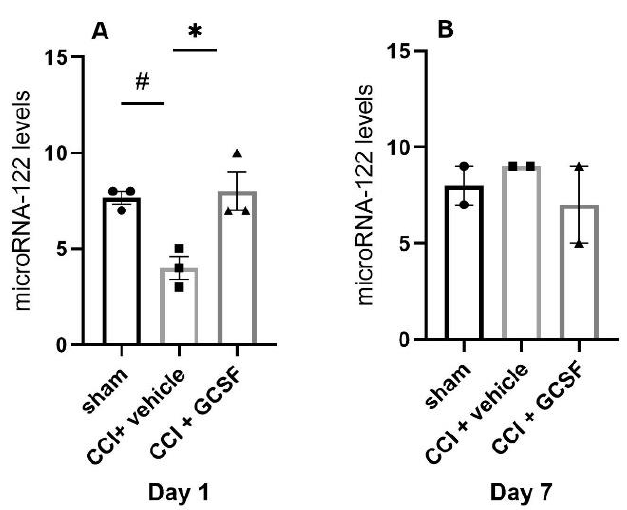
Figure 3. GCSF treatment upregulated the levels of microRNA-122 in the DRGs of CCI rats on the 1st day after nerve injury. MicroRNA-122 levels in the DRGs of the vehicle-treated CCI rats were significantly decreased compared to those in the DRGs of the sham-operated controls on the 1st day after nerve injury. In contrast, the microRNA levels in the DRGs of the GCSF-treated CCI rats were significantly higher than those in DRGs of the vehicle-treated CCI rats on the 1st day after nerve injury ( A ). There was no significant difference in microRNA-122 levels between sham-operated, vehicle-treated CCI, and GCSF-treated CCI rats on the 7th day after nerve injury ( B ). The other 419 screened microRNAs did not show a similar trend. The data are shown as the means ± SEMs (Day 1: n = 3 in each group; Day 7: n = 2 in each group; # p < 0.05: vehicle-treated rats compared to sham-operated rats; * p < 0.05: GCSF-treated CCI rats compared to vehicle-treated CCI rats, unpaired t -test between